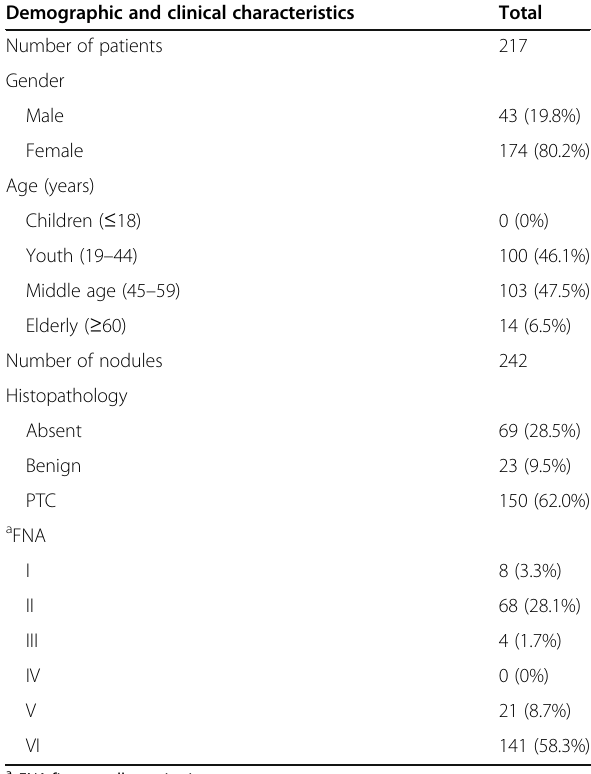
Table 1 Baseline demographic and clinical characteristics